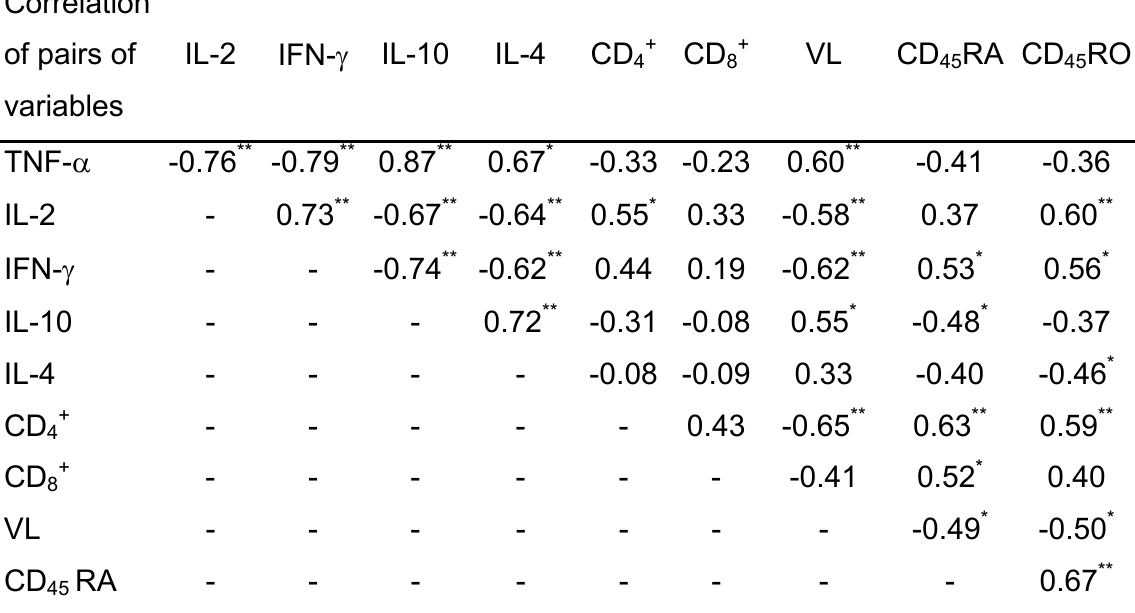
RA and CD RO cell 45 45